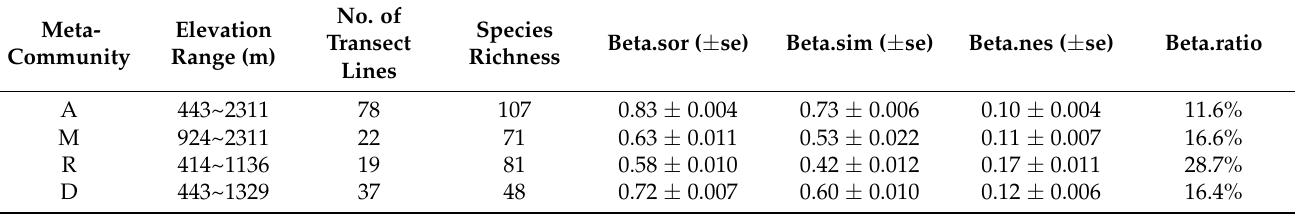
Table 1. Elevational range, number of transect lines (localities), number of species detected in more than two transect lines, pairwise dissimilarity values for Sørensen’s (beta.sor), Simpson’s (beta.sim), nestedness component (beta.nes), and the ratio of nestedness component to Sørensen’s dissimilarity (beta.ratio) in metacommunity A (localities in the whole study area), metacommunity M (localities in the mountain landscape), metacommunity R (localities in the riparian landscape) and metacommunity D (localities in the desert landscape). The Stand Error values of dissimilarity indices were calculated by locality pair